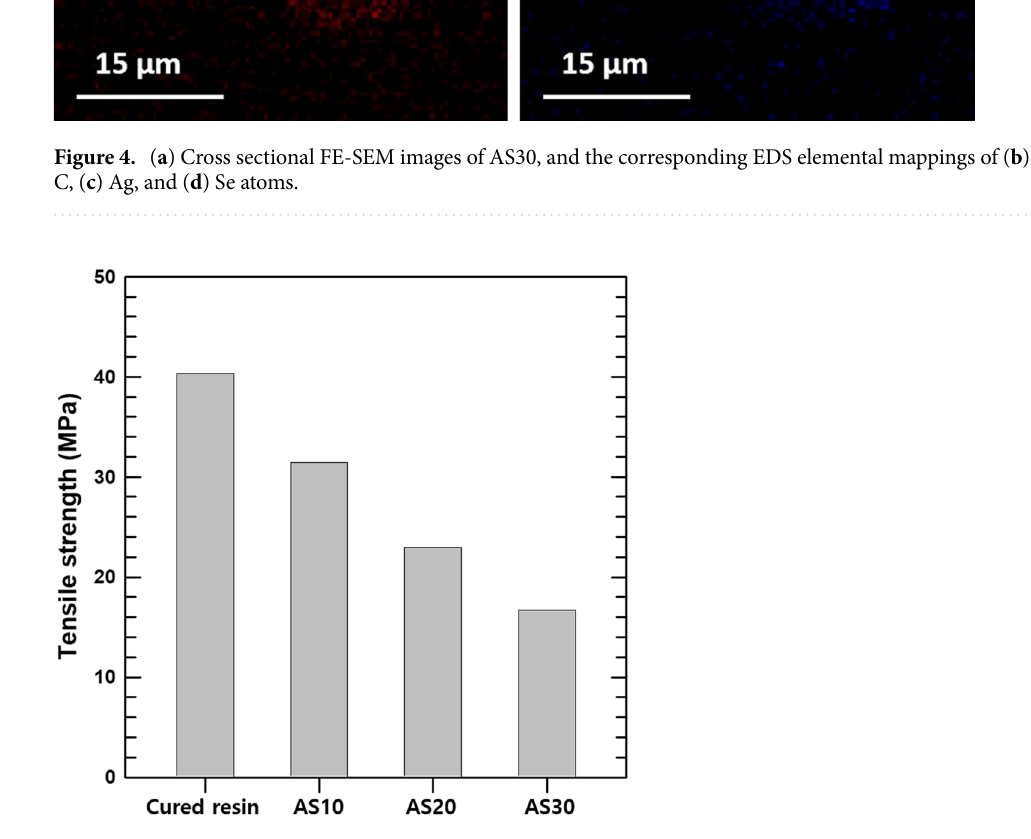
Figure 5. Tensile strength of various dog-bone shaped composite measured by